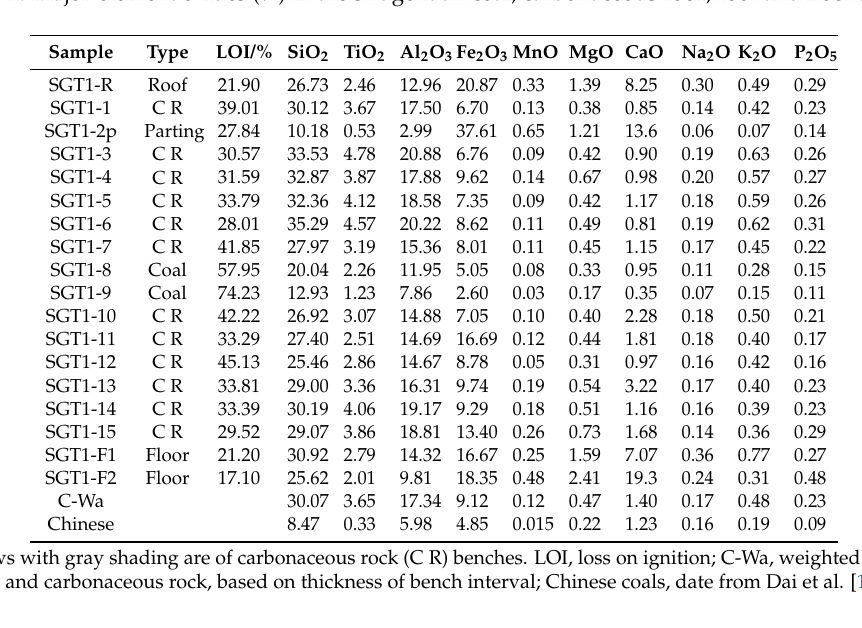
Table 2. Major-element oxides (%) in the Shugentian coal, carbonaceous rock, roof and floor strata. Sample